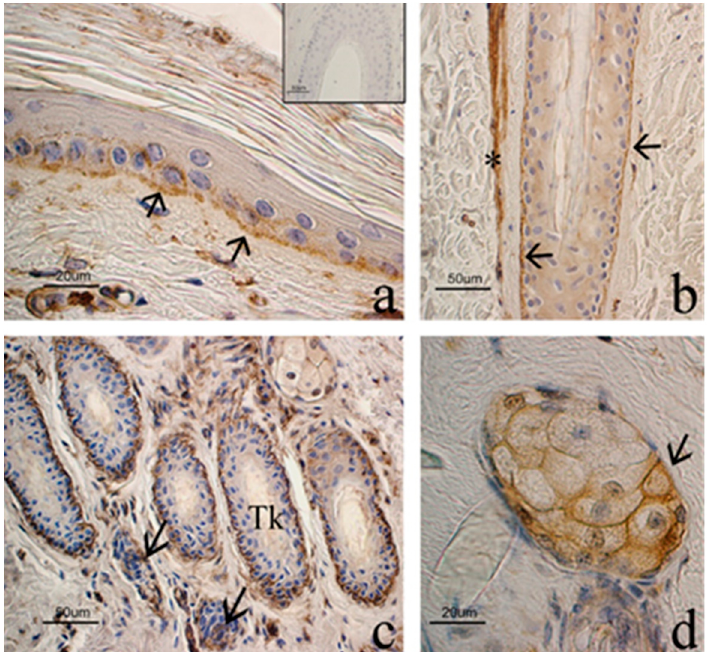
Figure 4. PDGFA expression in goat skin. ( a ) In the epidermis, the cells of the basal layer show a clear staining of the cell membrane (arrows), while suprabasal layers are negative. Negative control in the inset. ( b ) Isthmic region of an anagen hair follicle (HF): immunostaining is localized in the basal cells of the outer root sheath (arrows). * = arrector pili muscle. ( c ) A group of secondary regressive phase HFs, which are characterized by irregular edges of the outer root sheath and trichilemmal keratinization (TK). Basal cells surrounding the club hair show a strong immunostaining. Arrows point out two dermal papillae. ( d ) PDGFA expression in the sweat gland (arrow). ABC immunohistochemical staining. Nuclei are counterstained with Hematoxylin.